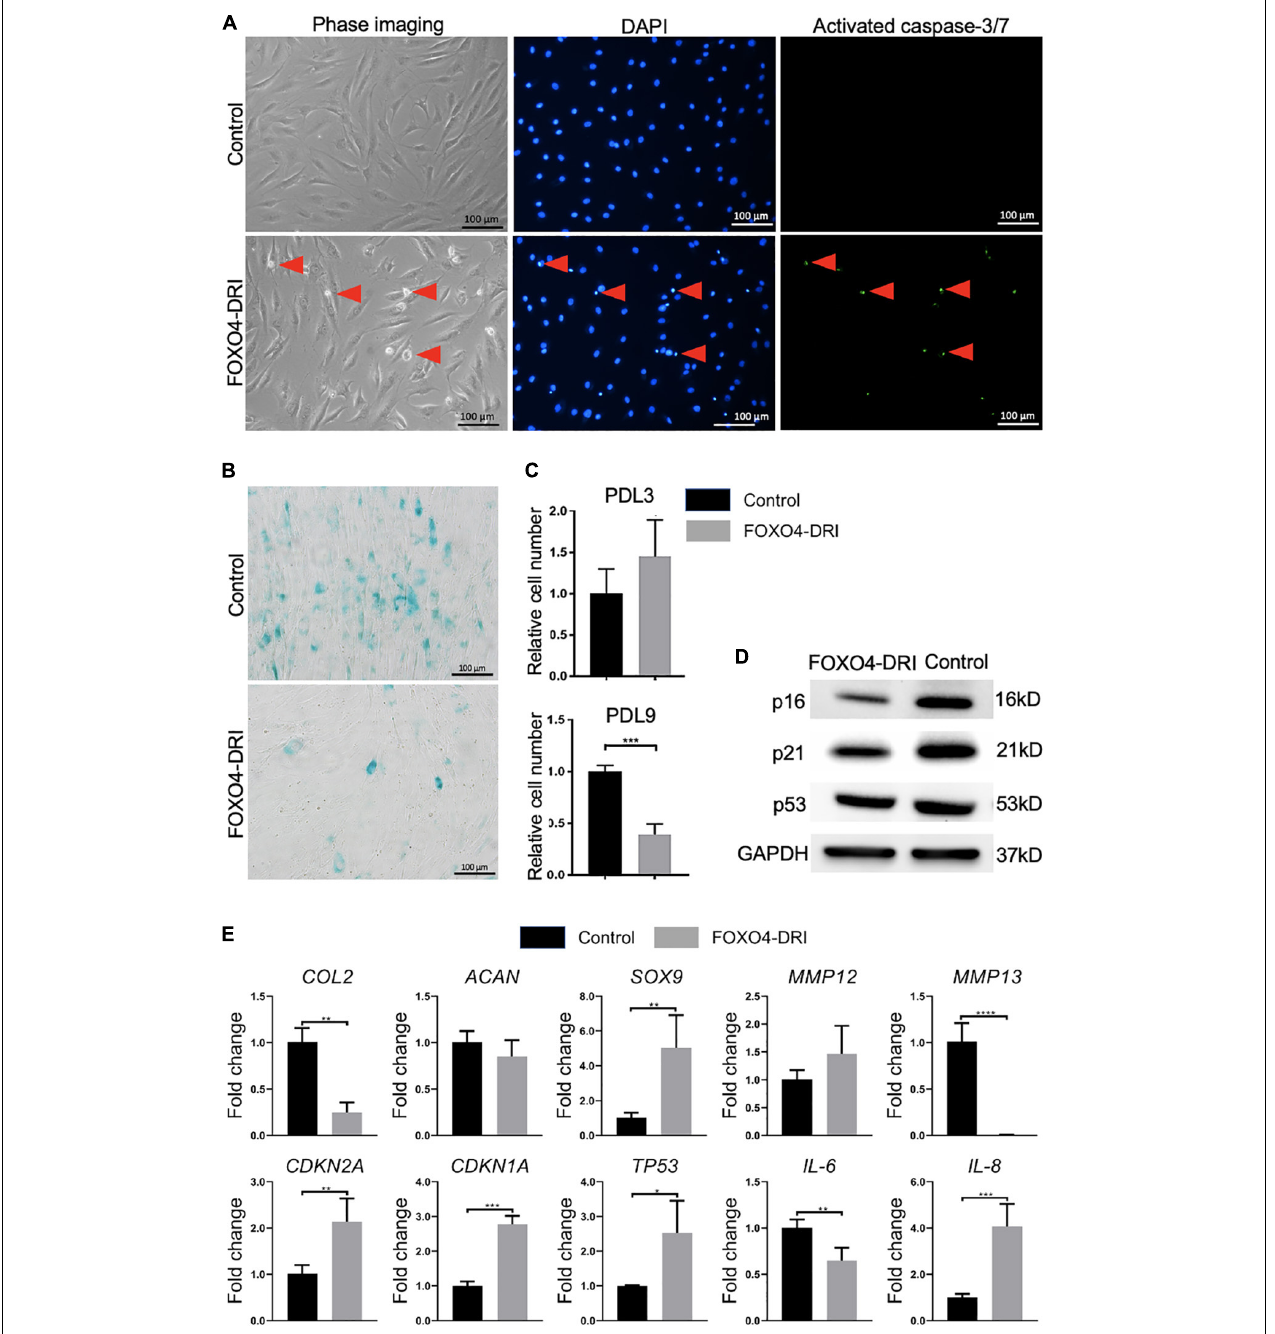
FIGURE 2 | Assessment of senescence level in PDL9 cells after FOXO4-DRI treatment. The samples with (FOXO4-DRI) or without (Control) FOXO4-DRI treatment were analyzed. (A) Detection of activated caspase-3/7. Red arrows indicate apoptotic cells. Bar = 100 µ m. (B) SA- β -gal staining. Bar = 100 µ m. (C) The relative cell number in PDL3 and PDL9 chondrocytes after FOXO4-DRI treatment was assessed using MTS assay. (D) Western blot. (E) Expression levels of selective genes. The data was normalized to that in Control group (set as 1). * p < 0.05; ** p < 0.01; *** p < 0.001; **** p <